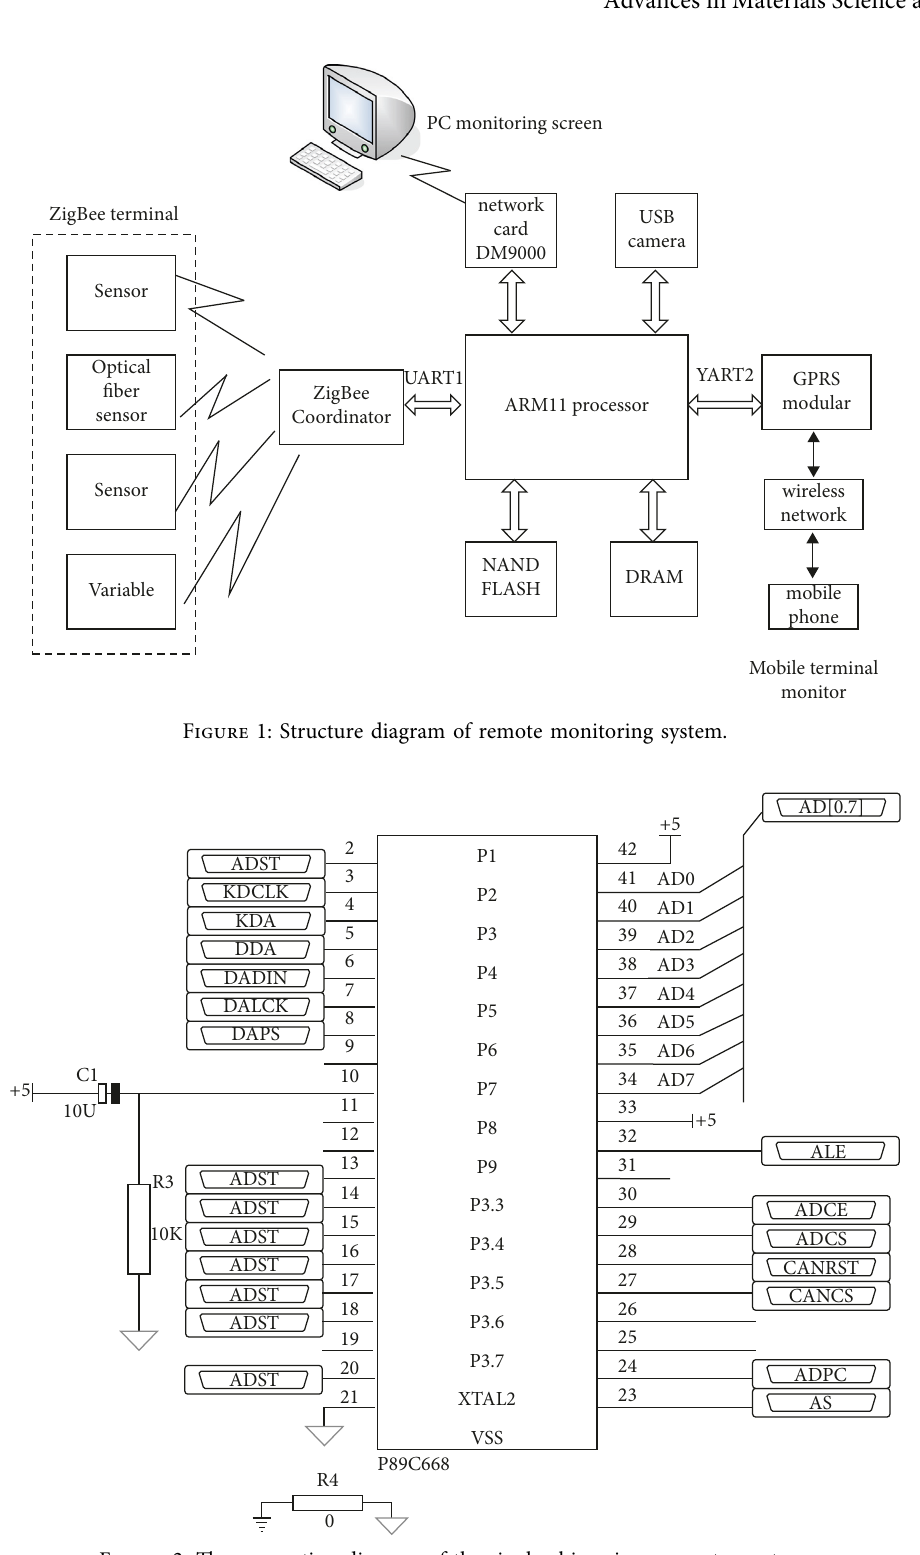
Figure 2: The connection diagram of the single-chip microcomputer